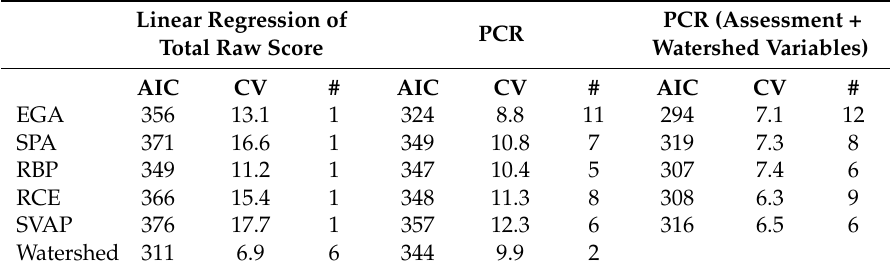
Table 7. Akaike’s Information Criterion (AIC) scores and cross-validation (CV) scores for three linear models to predict EPT taxa by five separate stream assessment methods and by watershed variables. The number of predictors (#) is also provided for each model.